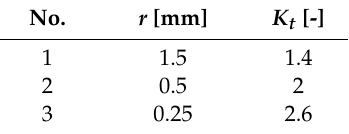
Table 2. Dimensions of the notched specimens.